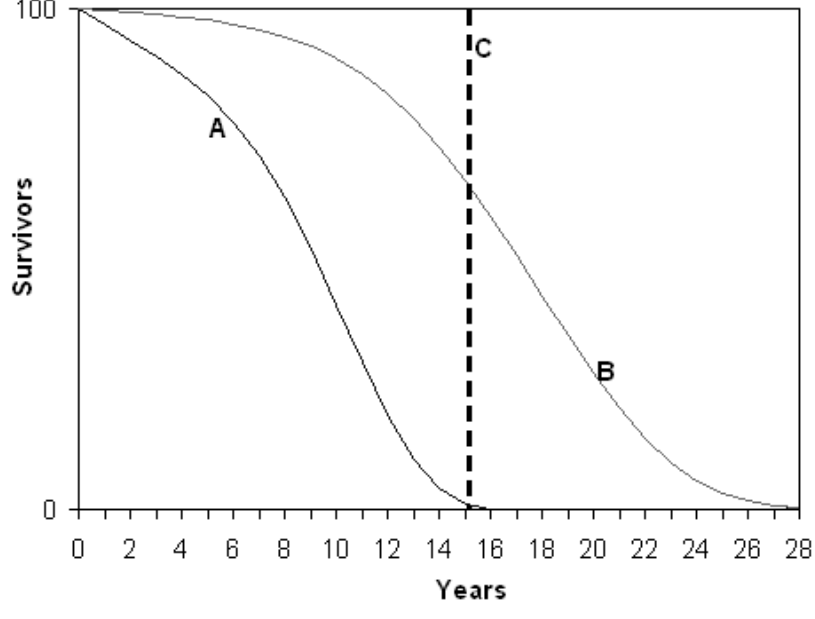
FIGURE 1. Curve A: Life table of an IMICAW species in the wild (Weibull’s equation has been used; data, from Ricklefs[54], are of Panthera leo : m o = 0.032, α = 2.52E-4, β = 3); curve B: